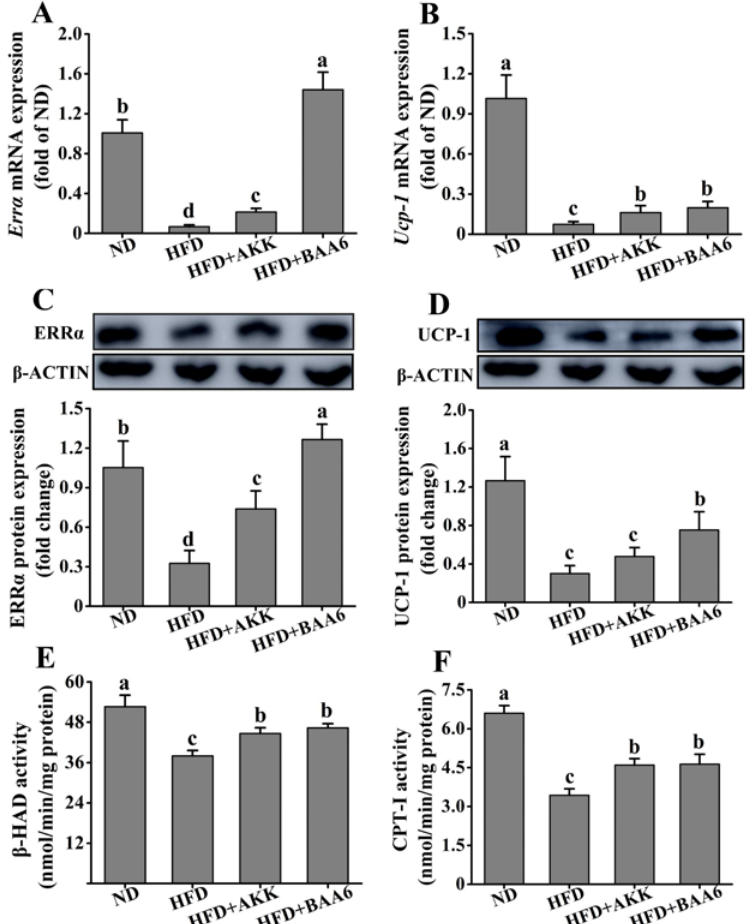
Figure 6. E ff ects of oral administration of BAA6 or AKK on mitochondrial function of epididymal fat tissues in HFD-fed mice. mRNA expression levels of ( A ) estrogen-related receptor α ( Err α )